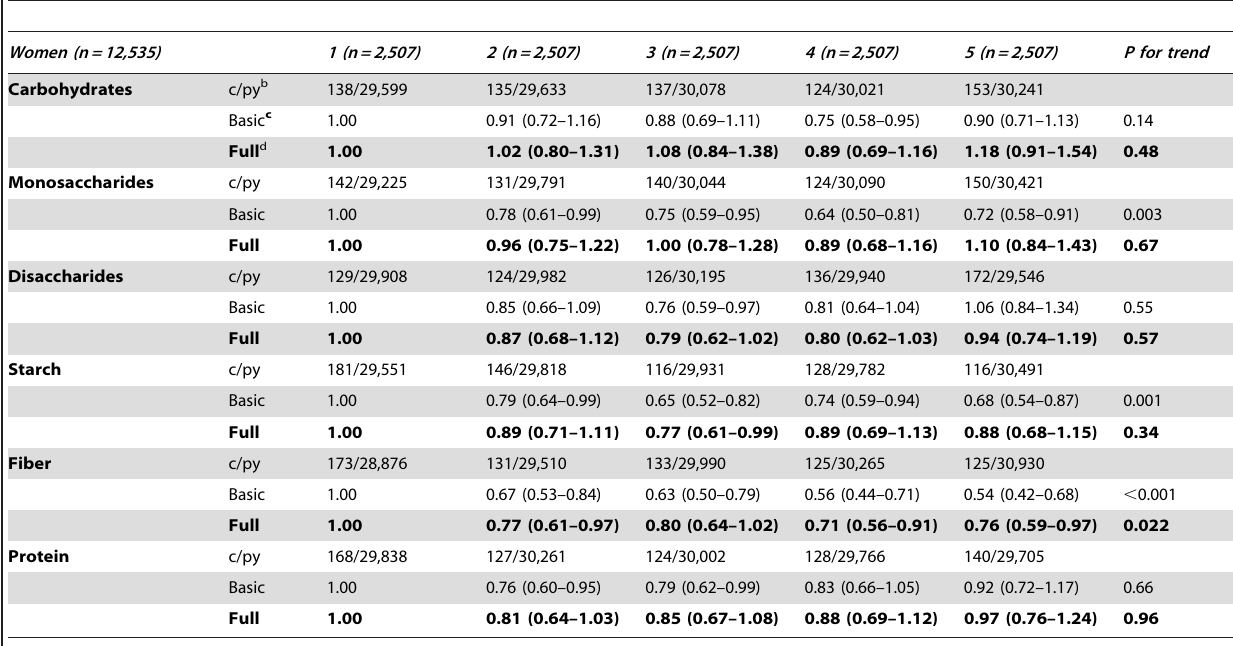
Table 3. Risk of total ischemic cardiovascular disease in 12,535 women (687 cases) a by intake of carbohydrates, fiber and protein (multivariate hazard ratios with 95% confidence intervals per quintile of energy-adjusted